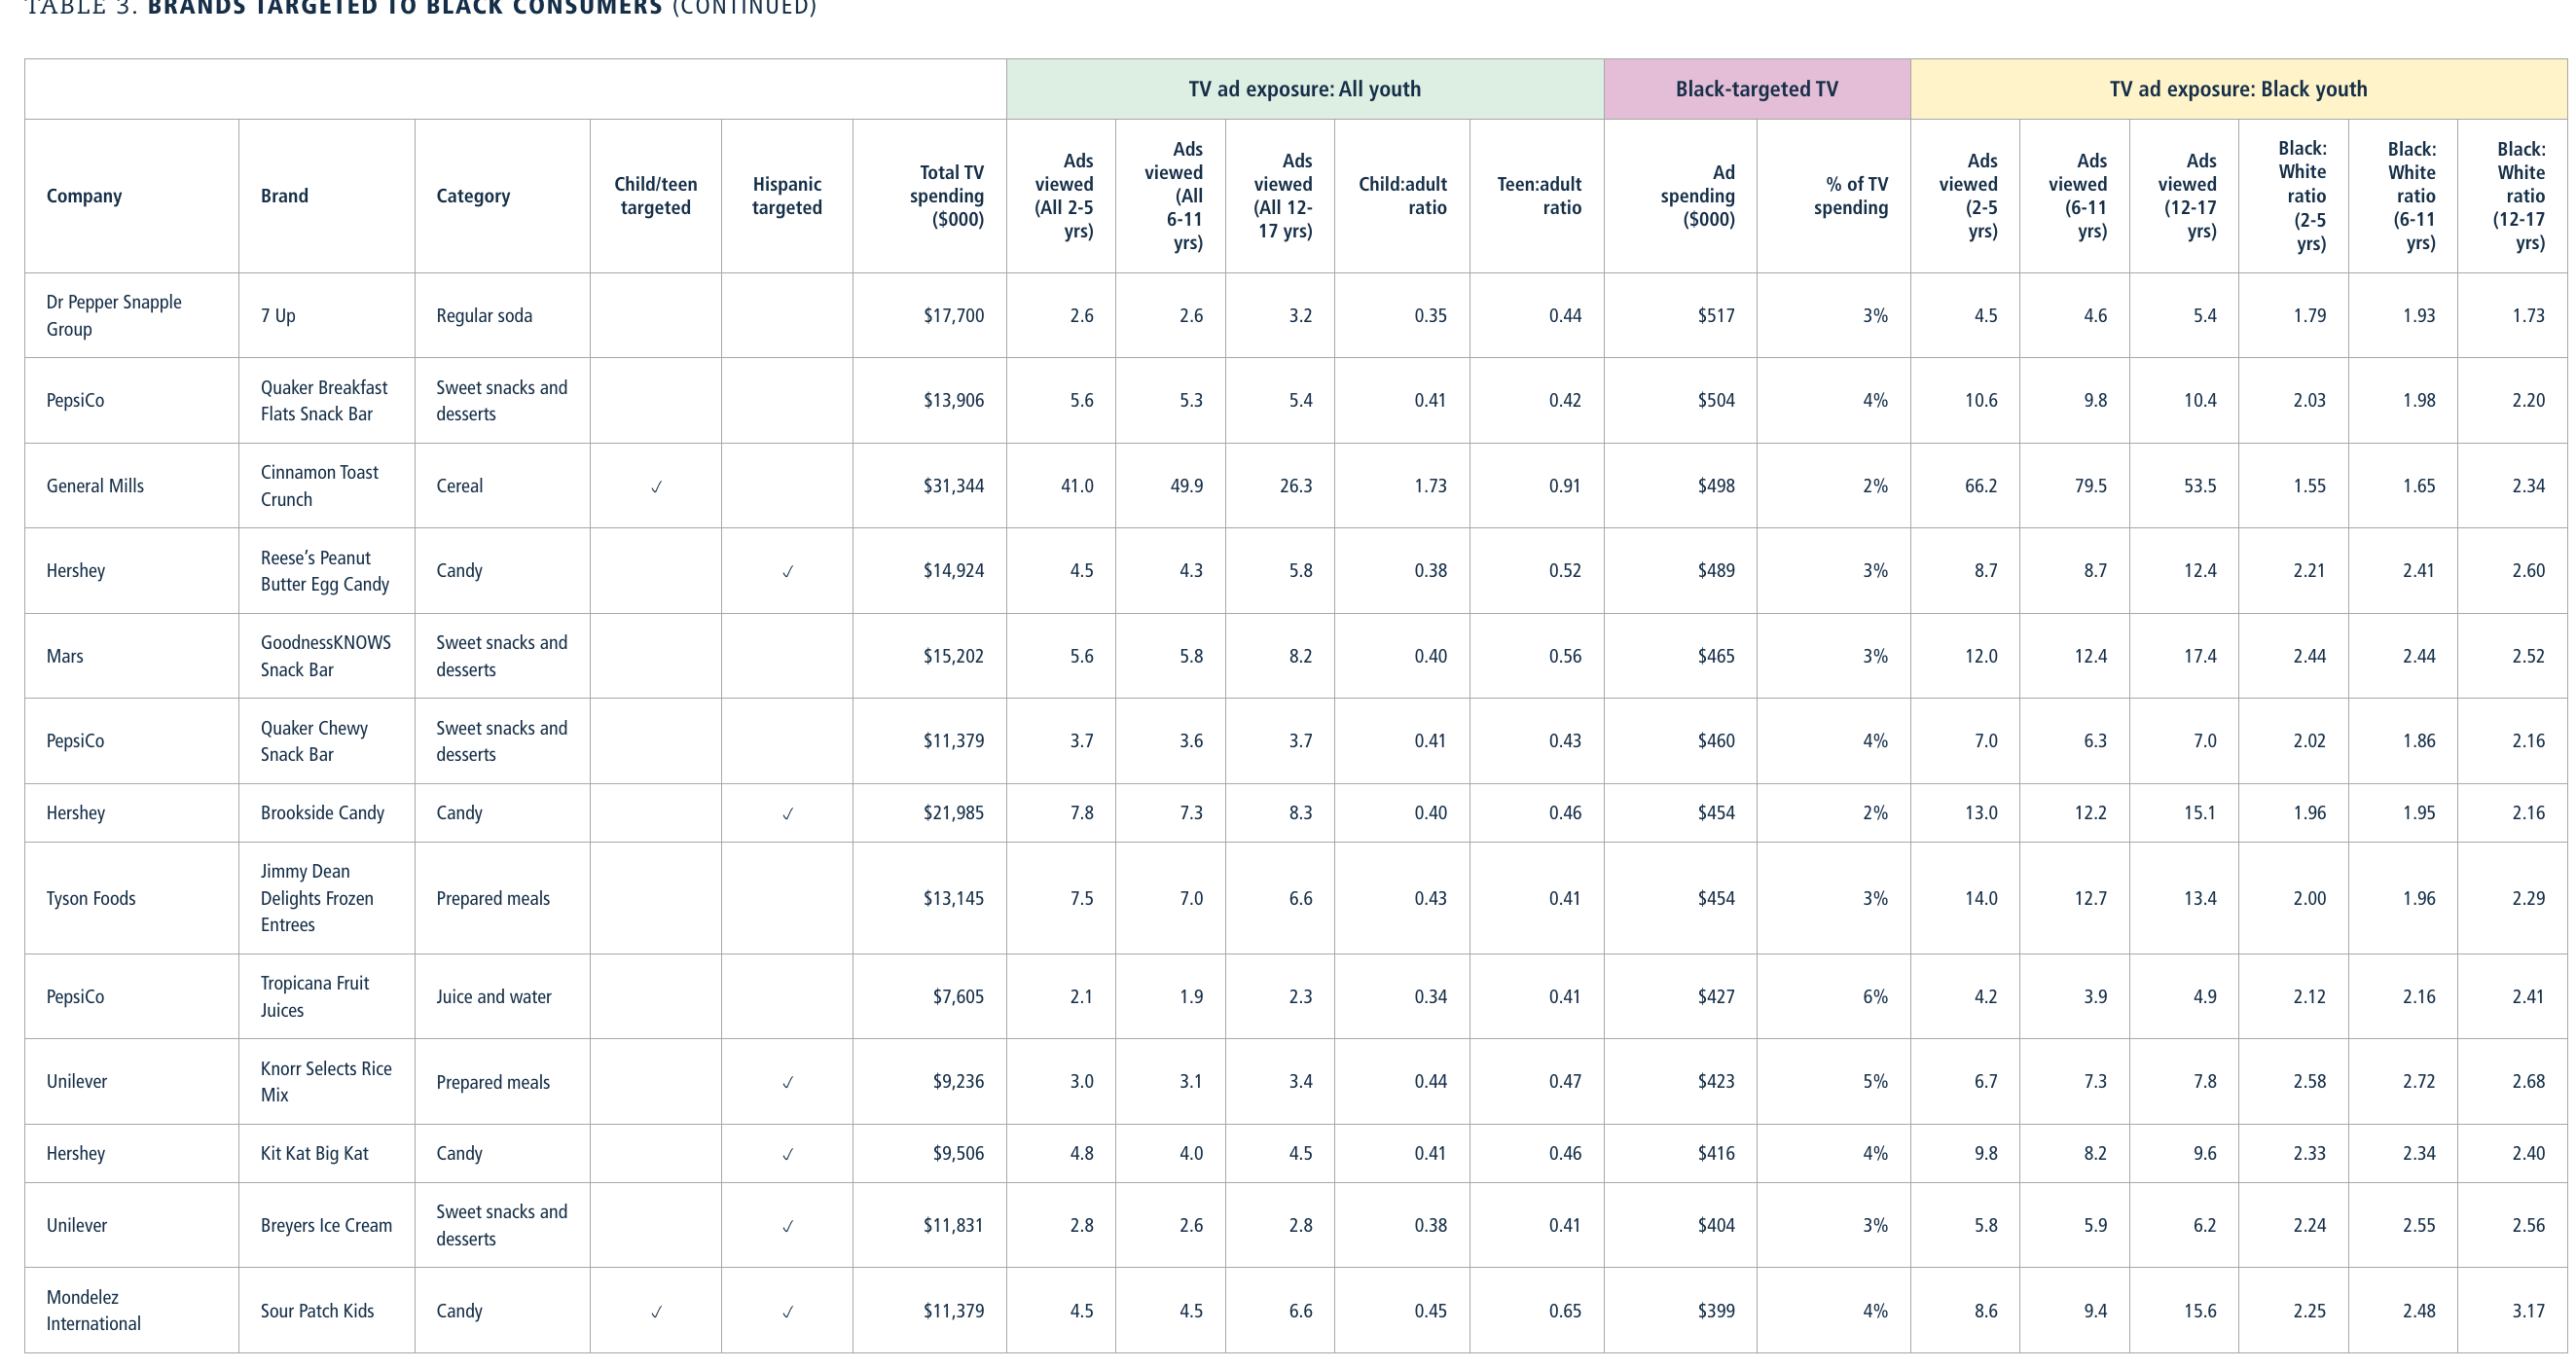
TABLE 3. BRANDS TARGETED TO BLACK CONSUMERS